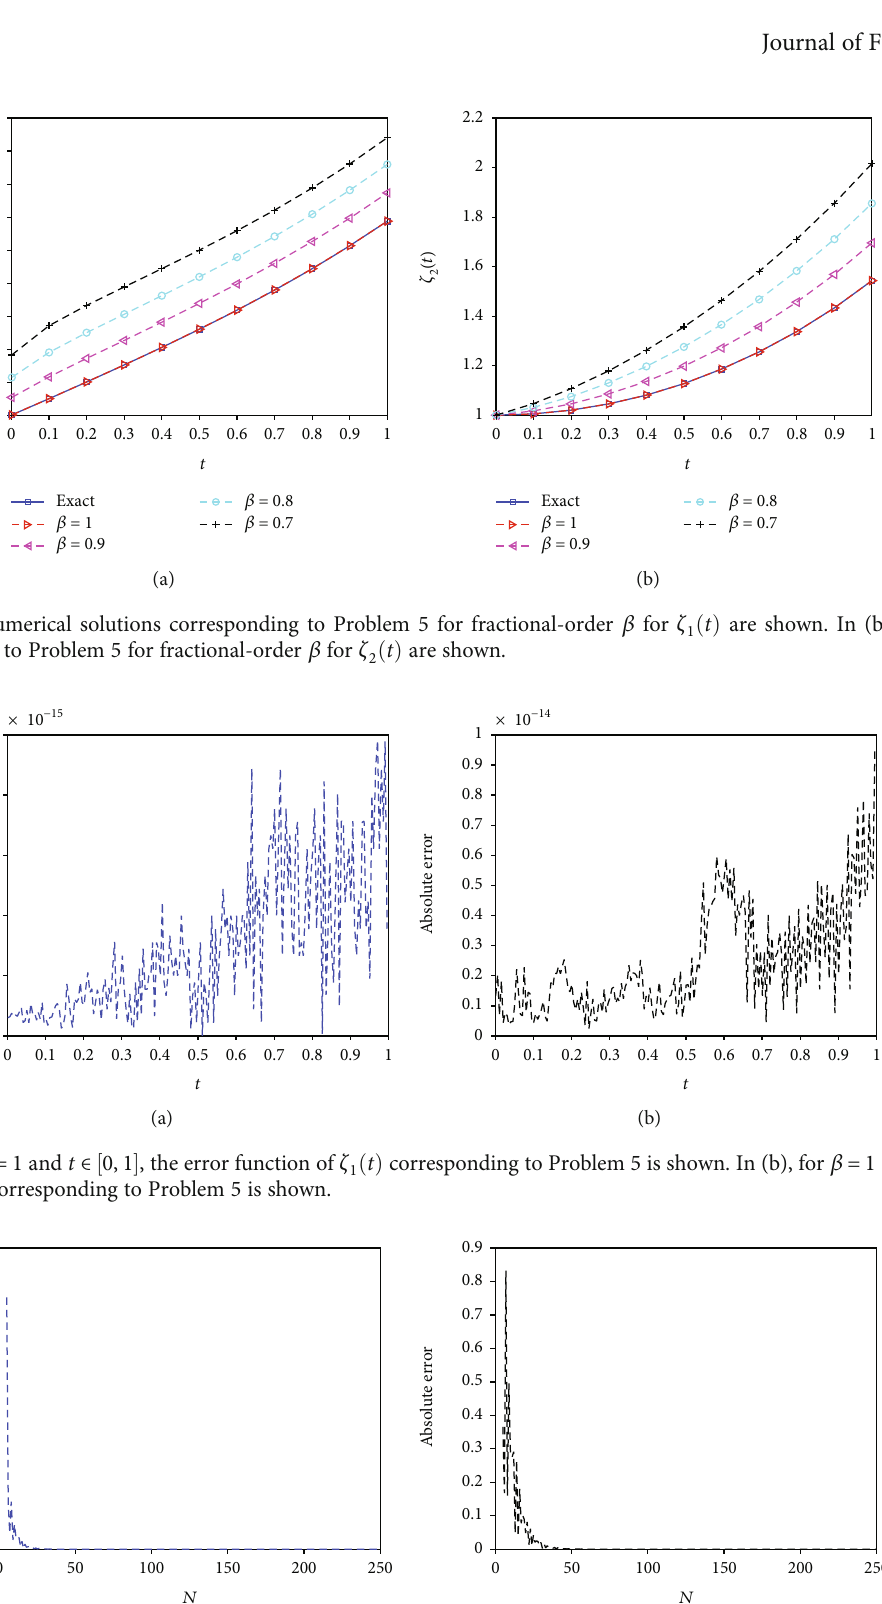
ð t Þ corresponding to Problem 5. In (b), the plot 1 ð t Þ corresponding to Problem 2